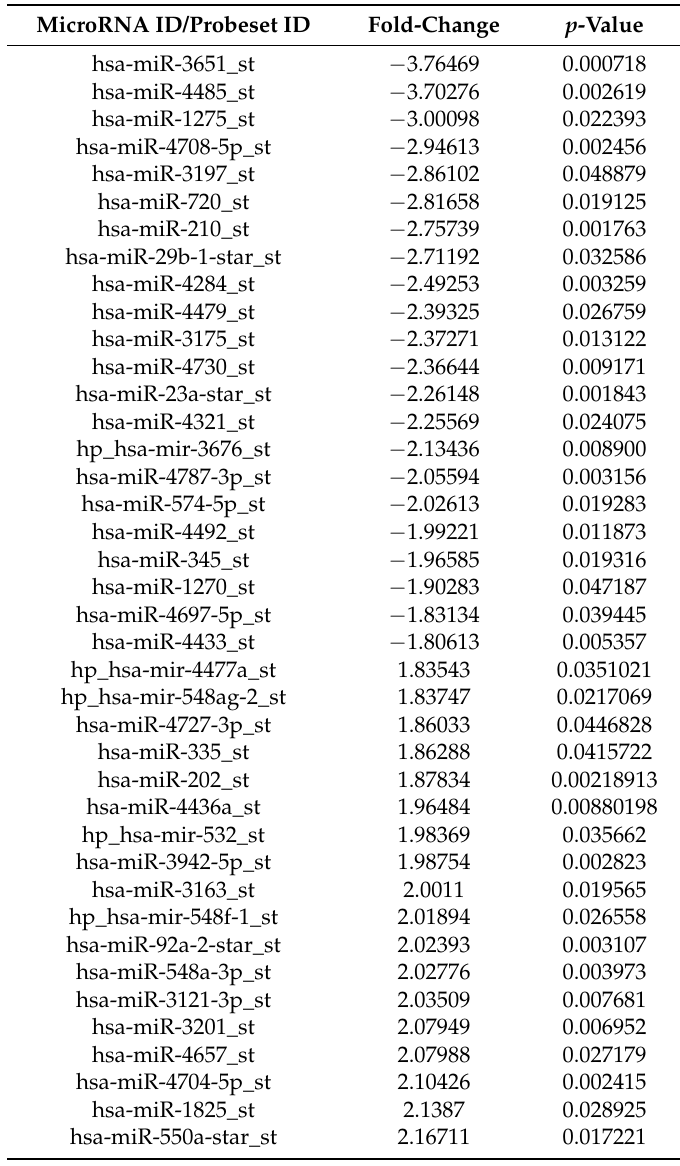
Table 1. Selected miRNAs differentially regulated in presence of vitamin C in human bone marrow stromal